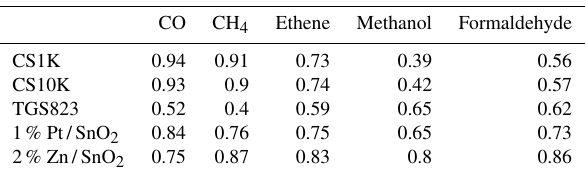
Figure 7. The batch firing process data over time recorded by op- erating the SF10SK fireplace. The transparent grey colouring indi- cates the high-temperature phase. (a) The variation in ROC with Tc. The horizontal blue dotted line (a) indicates the minimum ROC (about 4%). (b) The FTIR signals related to the concentrations of CO, CH 4 , formaldehyde, methanol, ethene and water vapour. (c) The sensor signals of the two CarboSen sensors with two lay- ers from the sensor array at 1% Pt/SnO 2 , 2% ZnO/SnO 2 and TGS823. Table 2. The Pearson correlation of the sensor signals with the main flue gas components as analyzed with the HT-FTIR gas analysis system (Fig.